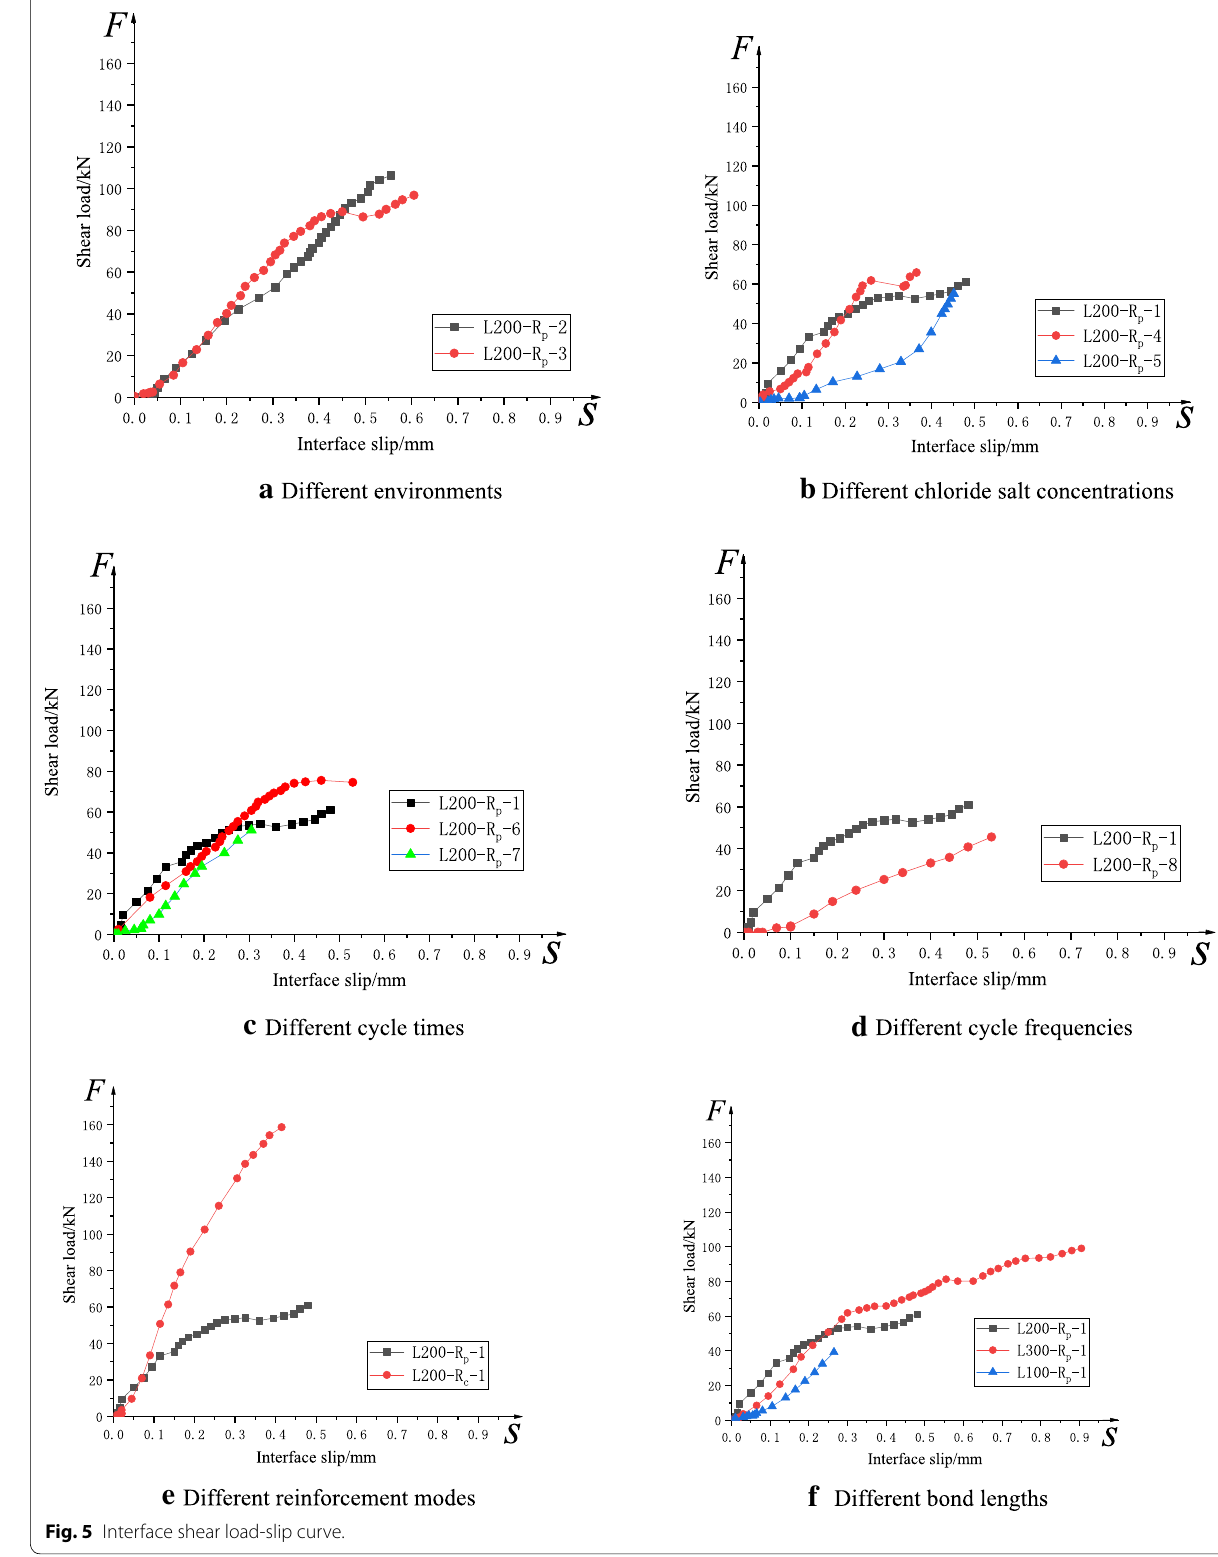
Fig. 5 Interface shear load-slip